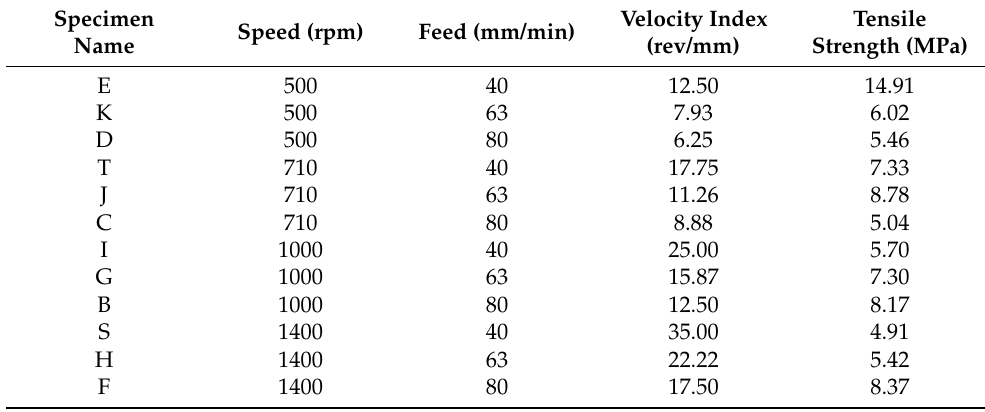
Table 6. Tensile strength for metal/polymer joint at different velocity indexes. Reprinted with permission from Ref. [78]. 2018, Anjal R. Patel et